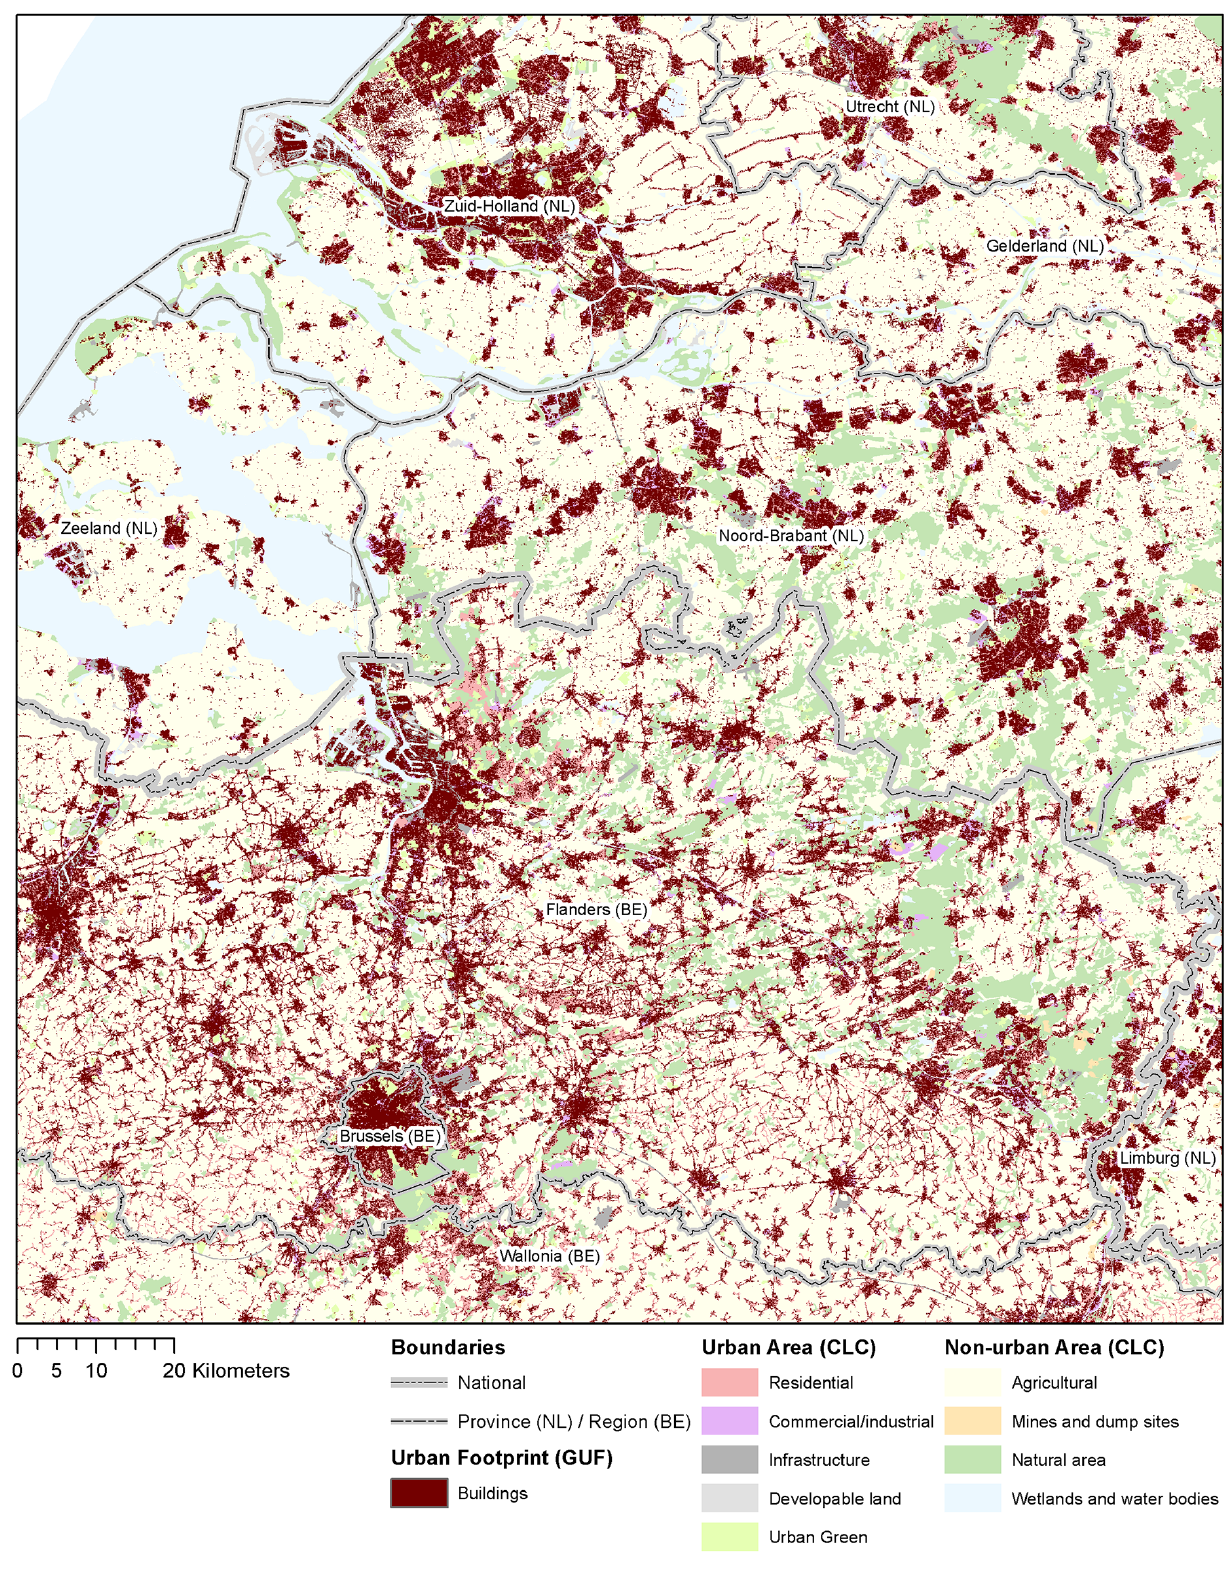
Figure 1. Urban morphology in Flanders and the Netherlands. Figure composed using Corine Land Cover 2012 (by Copernicus), Global Urban Footprint 2012 (by the DLR) and